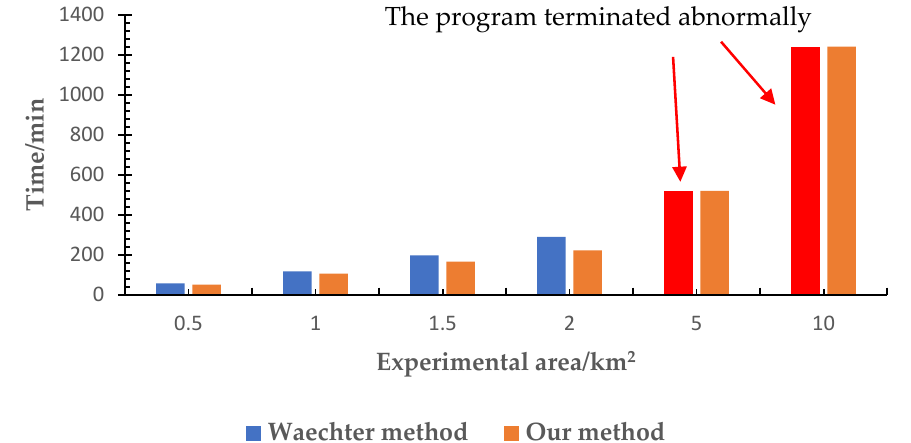
Figure 11. Bar graph for the time consumption comparison.